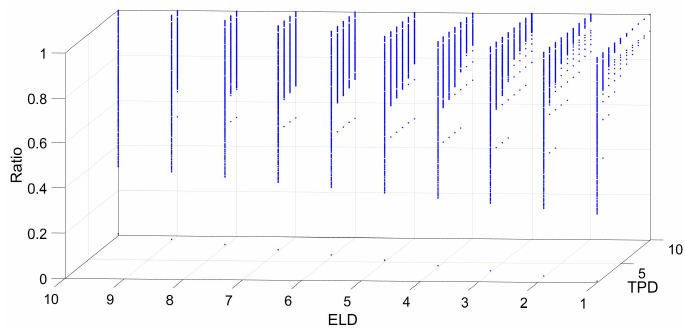
Figure 6. Output events generated by the LDSI algorithm depending on ELD and TPD values. An increase of events is produced when ELD increases. In the left corner of the graph, it is possible to see how low values of ELD at high values of TPD restricts the event production.